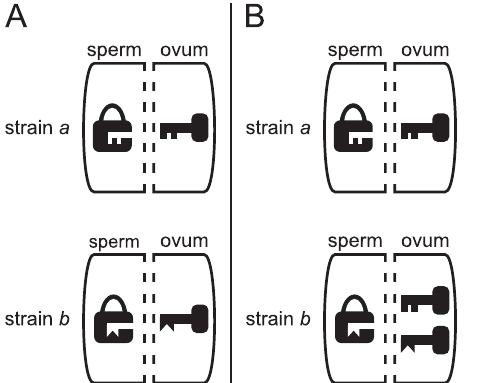
Figure 1. How bidirectionally and unidirectionally incompati- ble Wolbachia strains are represented in the lock-key-model. (A) strains a and b are bidirectionally incompatible: Neither a nor b has the key to each other’s lock. (B) a and b are unidirectionally incompatible: b has the key to a ’s lock, but a does not have the key to b ’s lock.